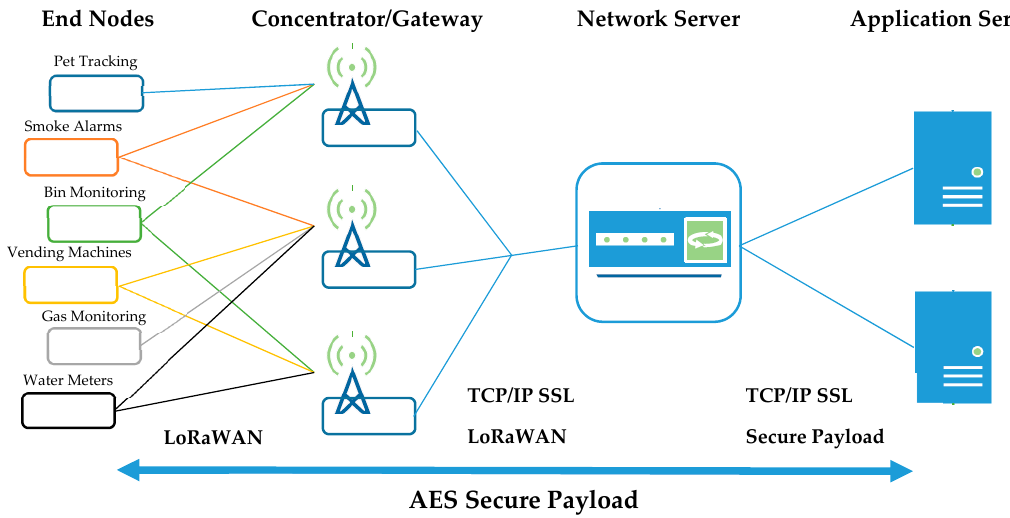
Figure 27. Data Packet life-cycle.